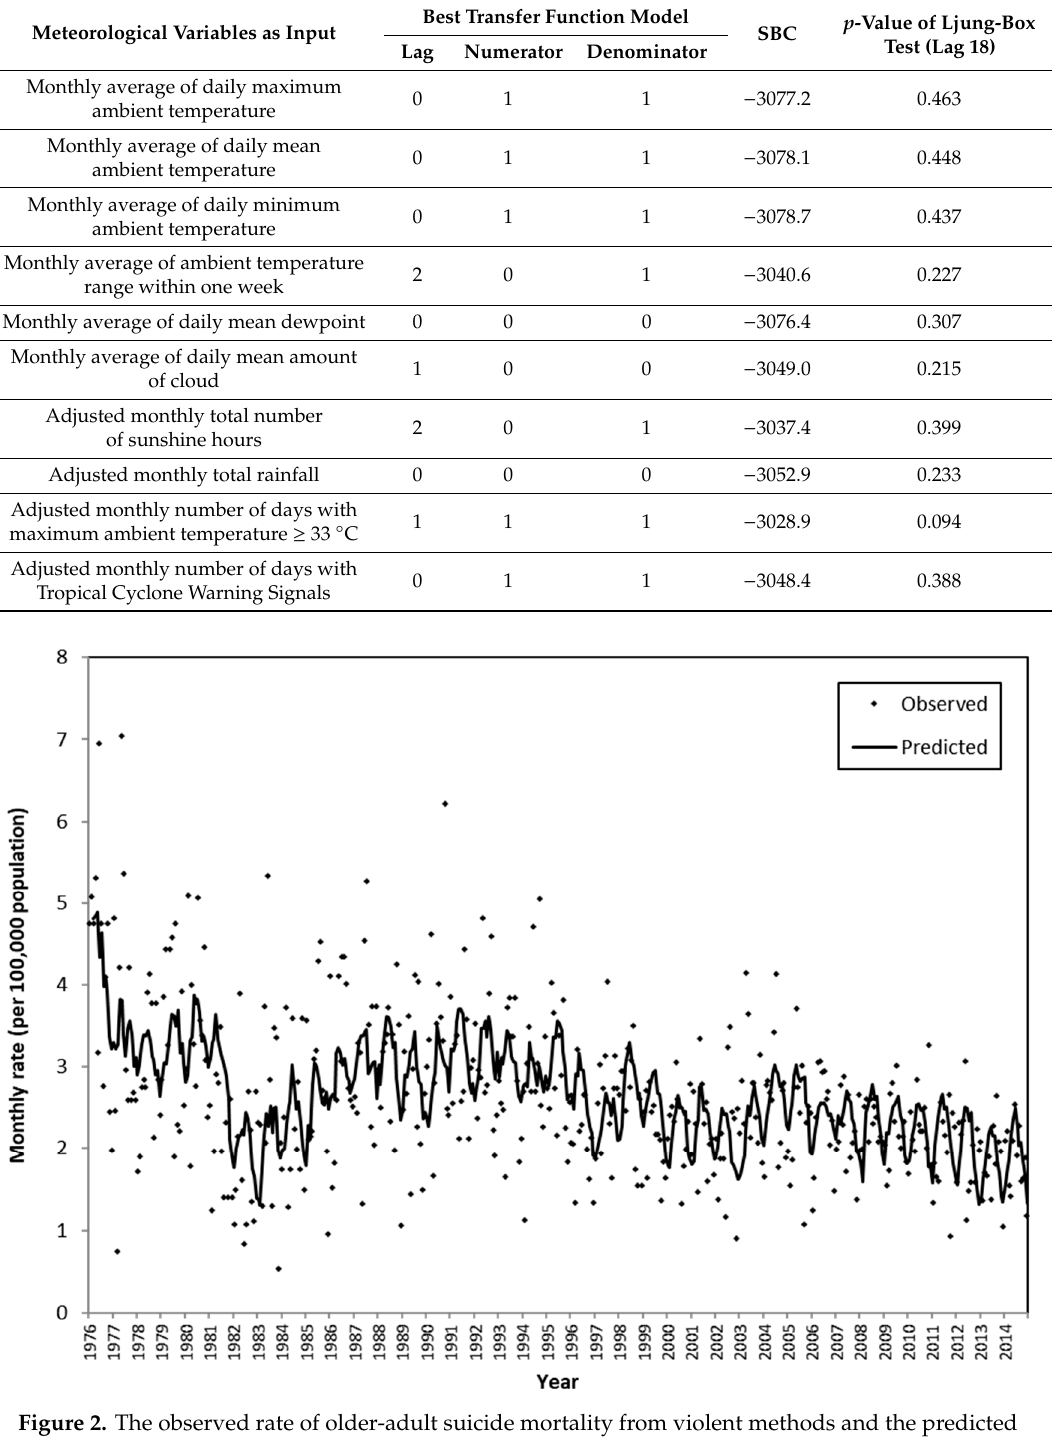
Figure 2. The observed rate of older-adult suicide mortality from violent methods and the predicted rate based on the transfer function model that featured monthly average daily minimum ambient temperature as the input series.